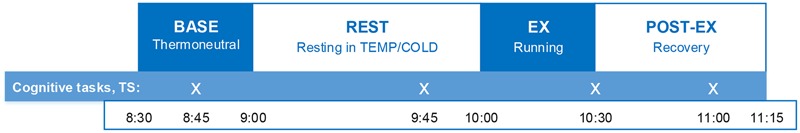
Experimental protocol.